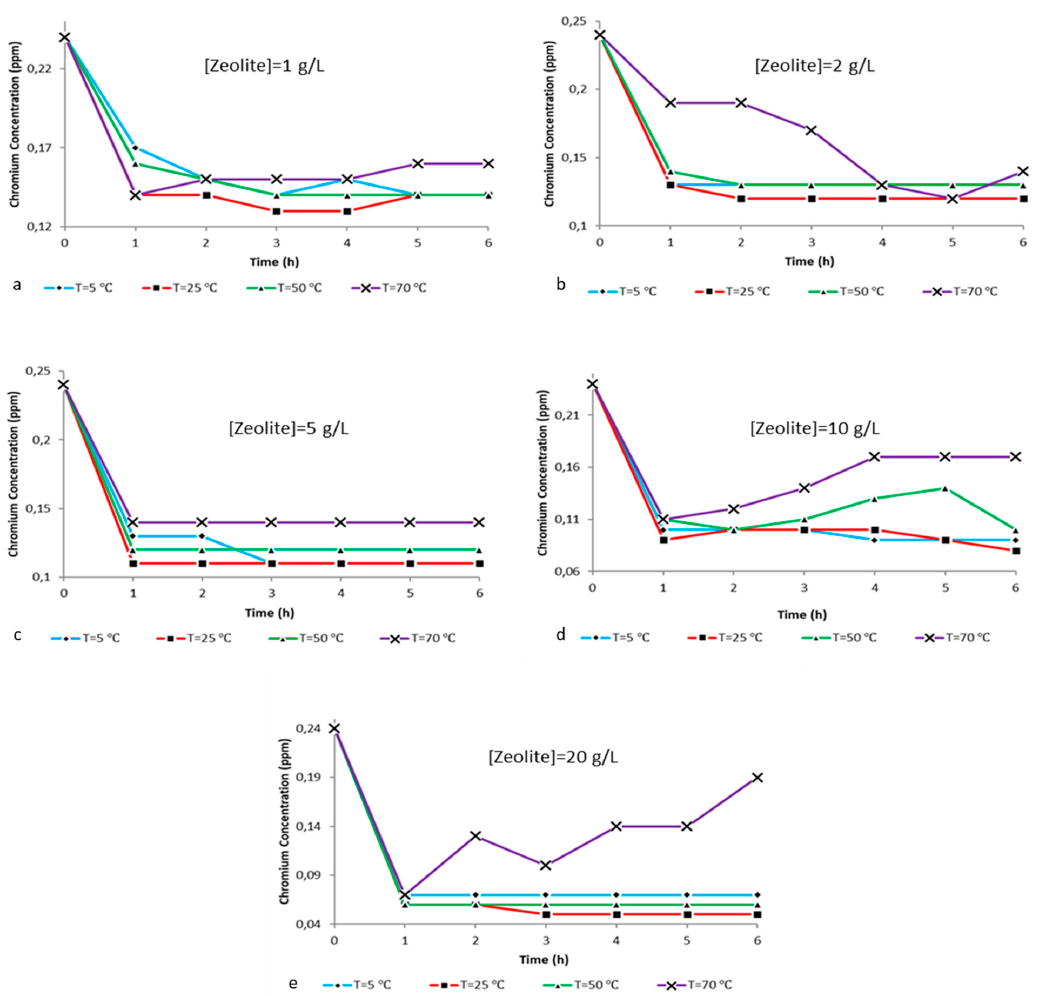
Figure 8. Chromium ion concentration vs time at different temperatures (5 °C, 25 °C, 50 °C and 70 °C) and pH 5.5 for the ratios ( a ) 2:1 g/L, ( b ) 2:2 g/L, ( c ) 2:5 g/L, ( d ) 2:10 g/L and ( e ) 2:20 g/L potassium dichromate:zeolite X.